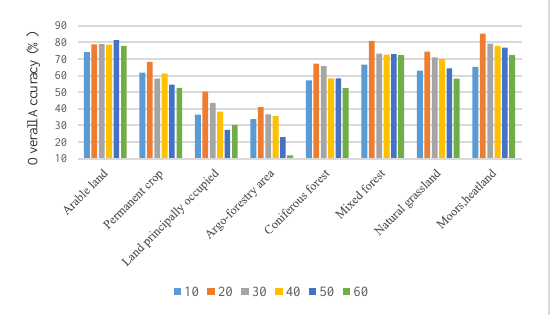
Figure 7. Average of overall accuracy obtained from the second experiment (with fine-tuning the parameters) on Sentinel-2 image for each class with ResNet 50 network.